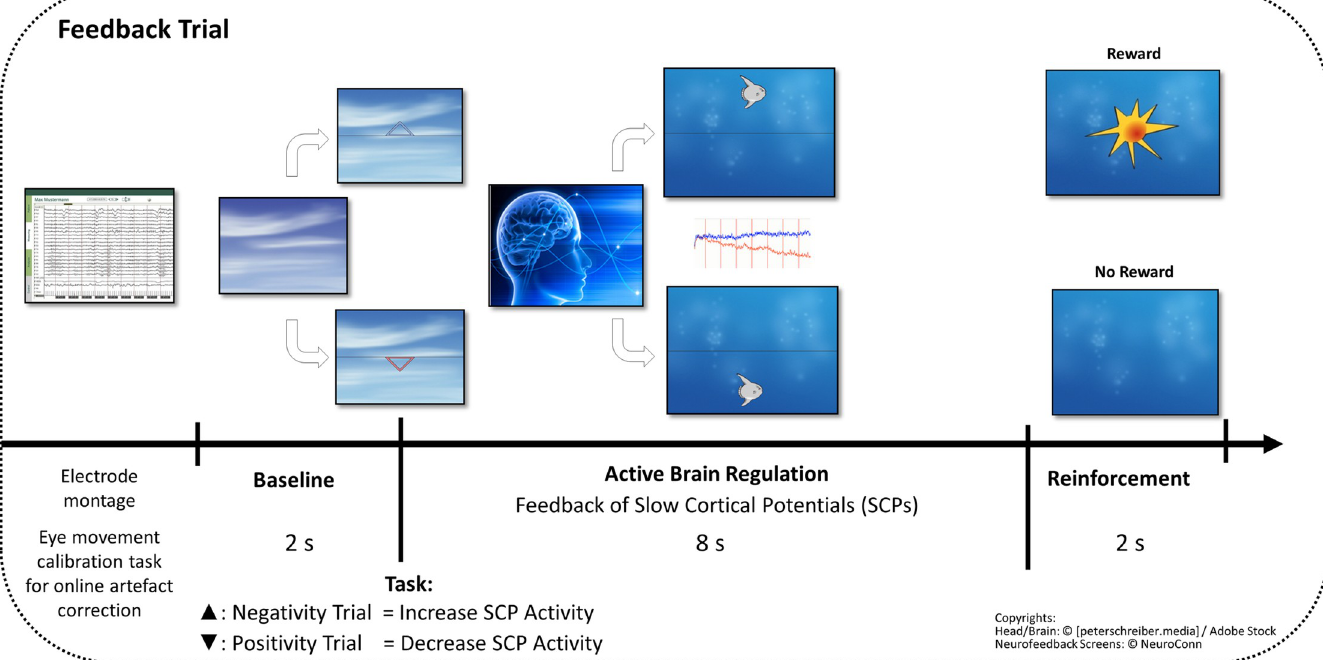
Fig 1. SCP neurofeedback procedure.